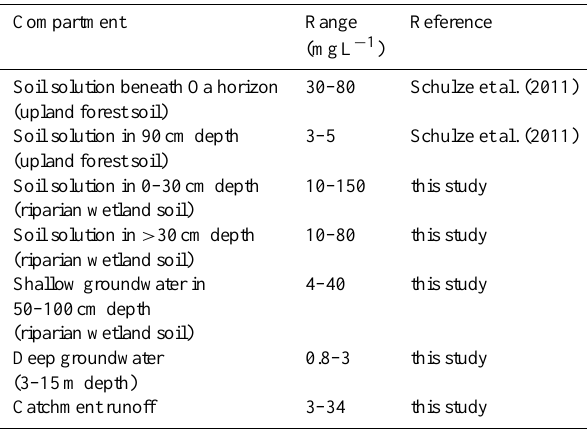
Table 1. Range of DOC concentrations in different compartments of the Lehstenbach